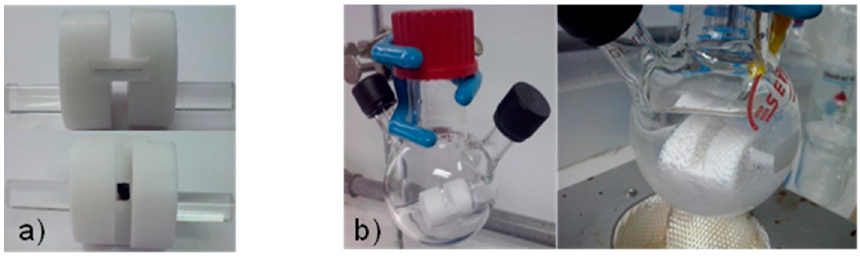
Figure 2. ( a ) Teflon device used for the growth of ZnO nanostructures on an anodized aluminum substrate; ( b ) experimental setup used for the growth of ZnO